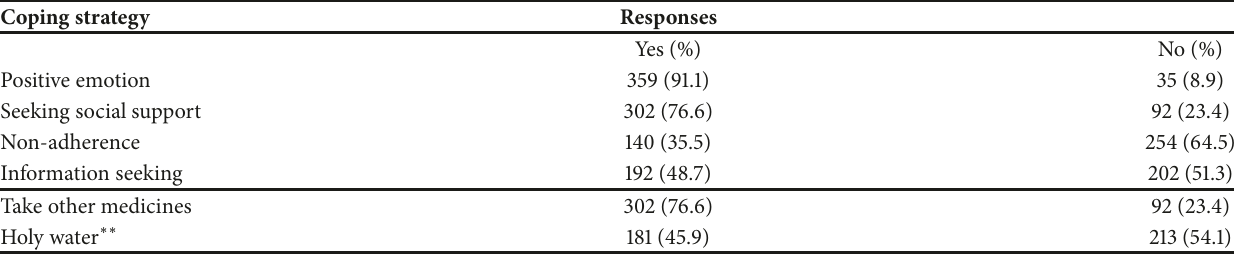
Table 6: Responses for each coping strategy for adverse effects of ART by HIV patientswho were attending HIV clinic at UoGRH.